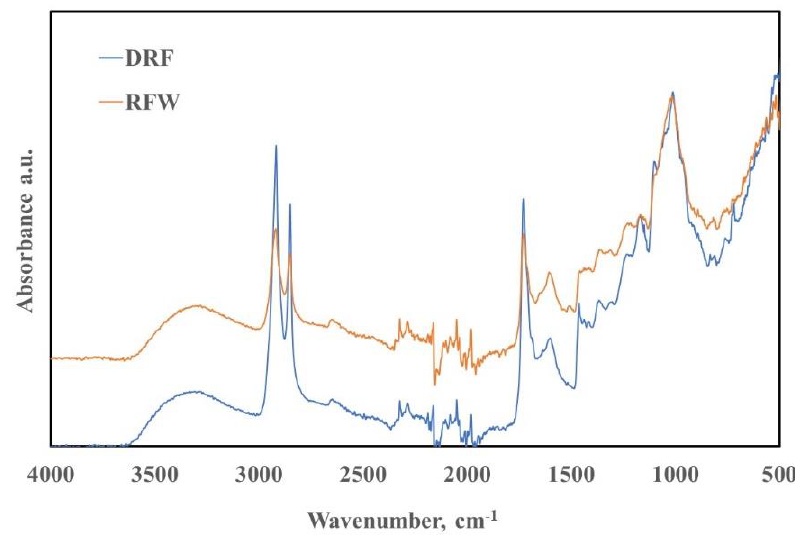
Figure 1. ATR-FTIR spectra of dry rose flower (DRF) and rose flower waste (RFW), before and after essential oil extraction, respectively.